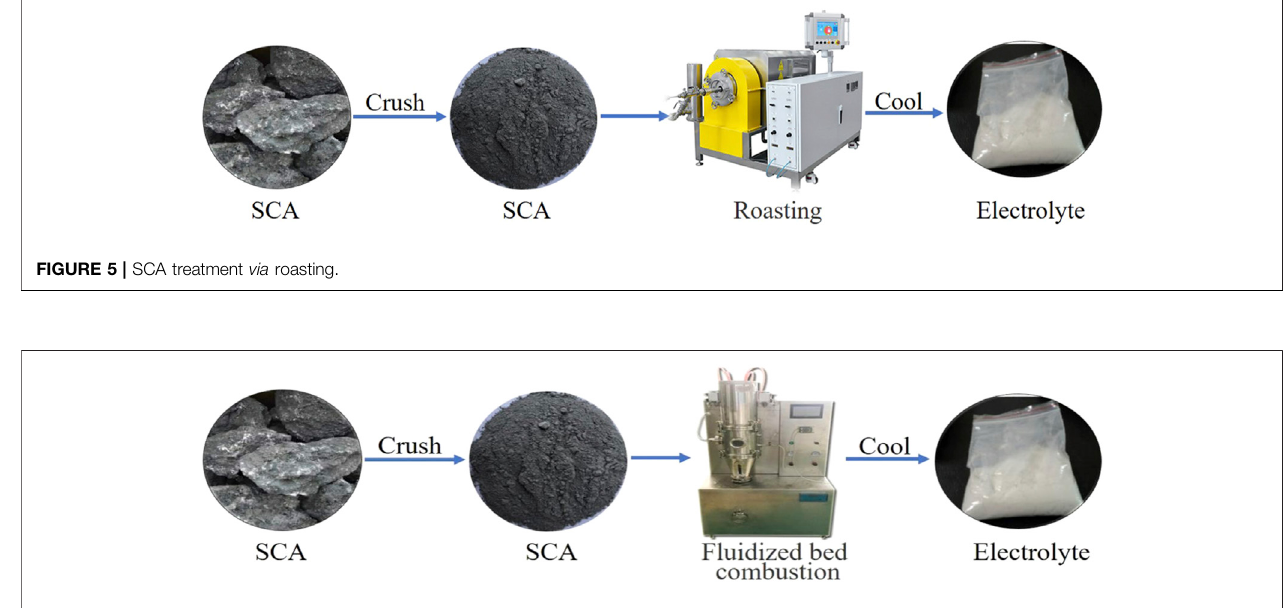
FIGURE 6 | SCA treatment via bubbling fl uidized bed